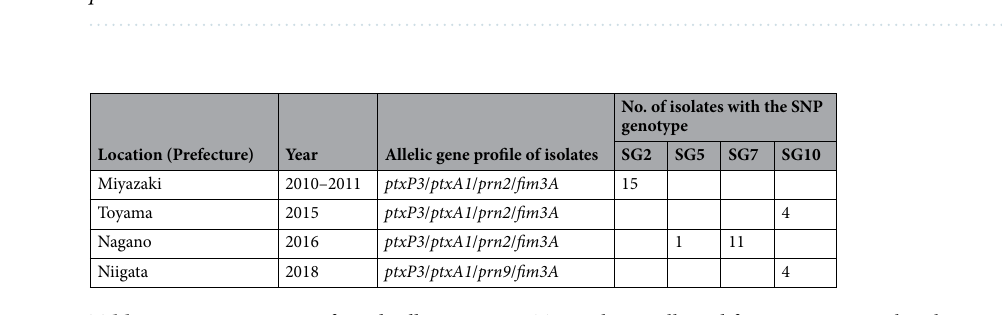
Table 5. SNP genotypes of Bordetella pertussis MT27 isolates collected from pertussis